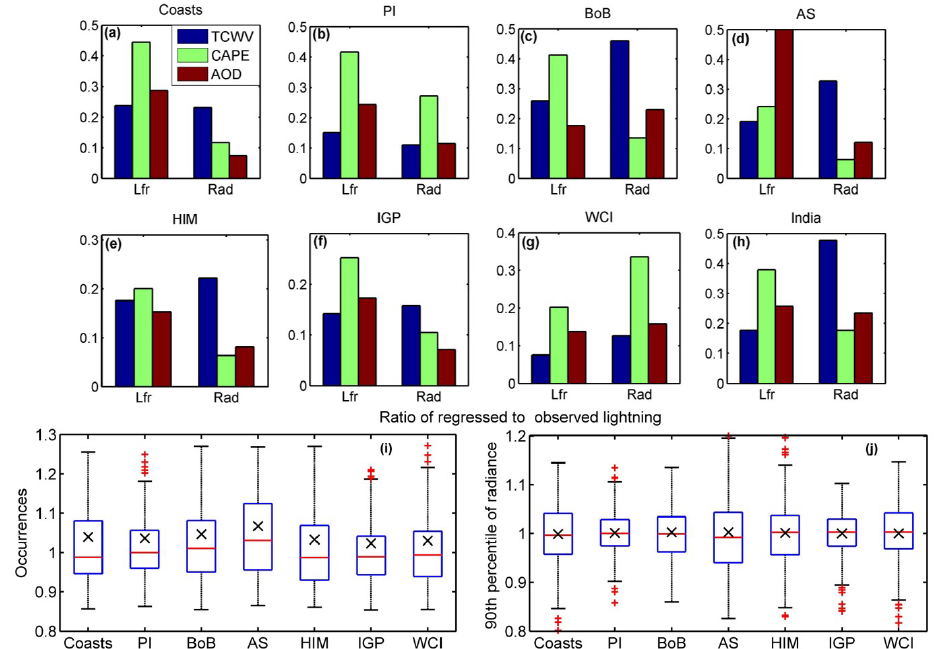
Figure 4. Temporal dominance analysis MLR coefficients of TCWV, CAPE and AOD for lightning frequency and radiance over the (a) Coasts, (b) PI, (c) BoB, (d) AS, (e) HIM, (f) IGP, (g) WCI and (h) India-wide regions. (i, j) The zonal distribution of ratios between the regressed and observed lightning frequency (Lfr) and the 90th percentile of radiance (Radp90) over seven Indian